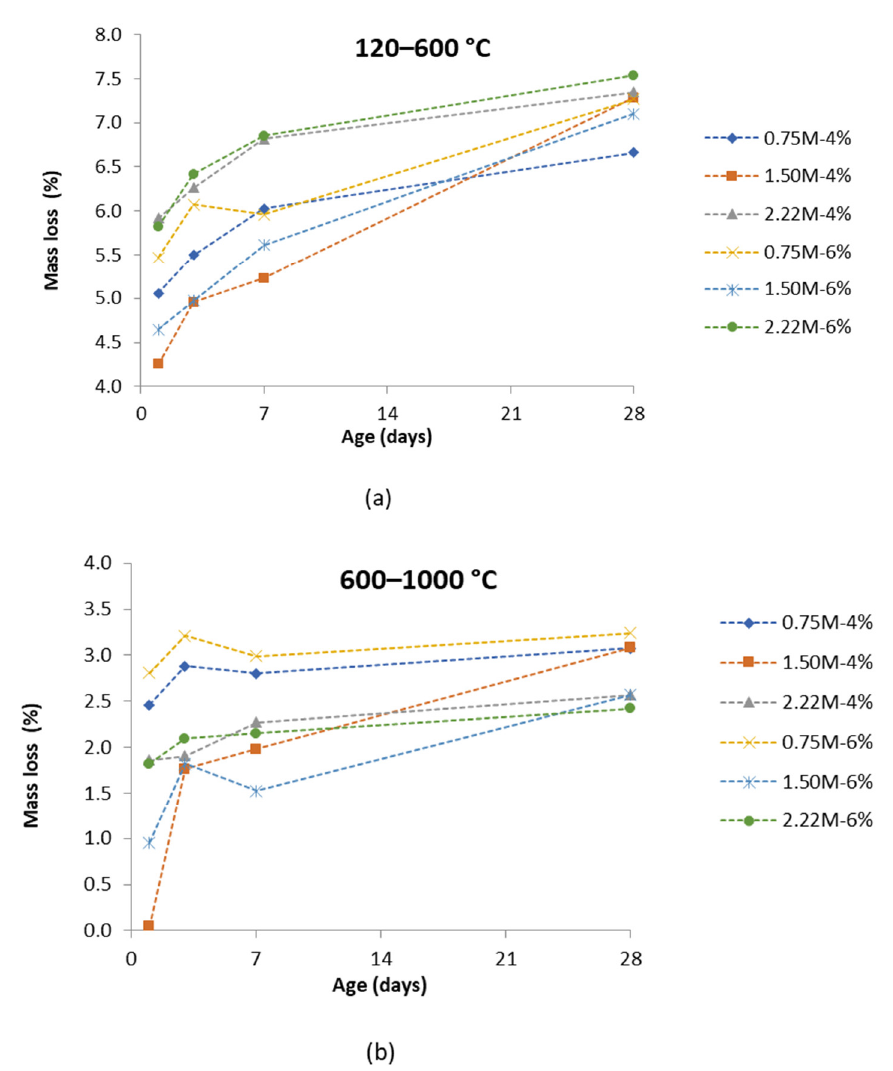
Figure 12 . Mass losses (%) for all pastes after 1, 3, 7 and 28 days of curing in different temperature ranges: ( a ) 120–600 °C and ( b ) 600–1000 °C.